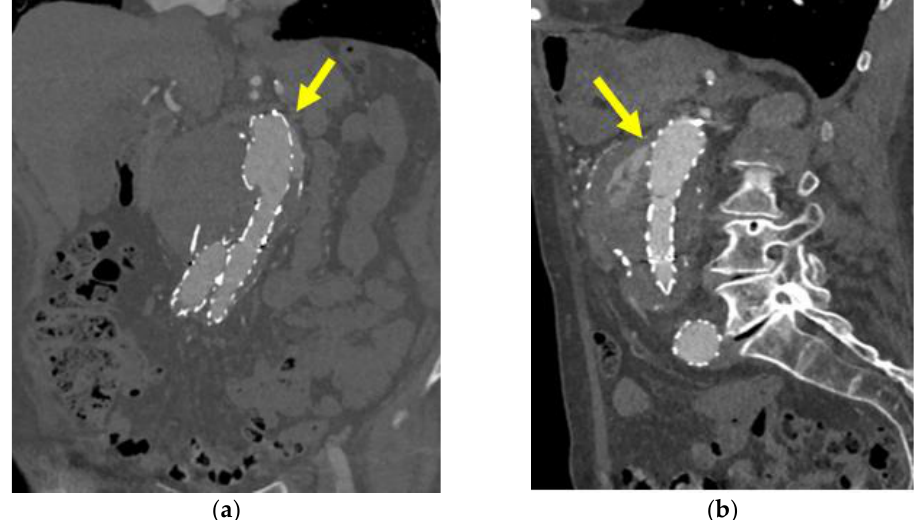
Figure 2. CTA demonstrating a type Ia endoleak after infrarenal endovascular aneurysm repair for AAA: ( a ) coronal and ( b ) sagittal views demonstrate the contrast flow (yellow arrow) within the aneurysm sac entering from the proximal end of the stent-graft; CTA, computed tomography angiography; AAA, abdominal aortic aneurysm.